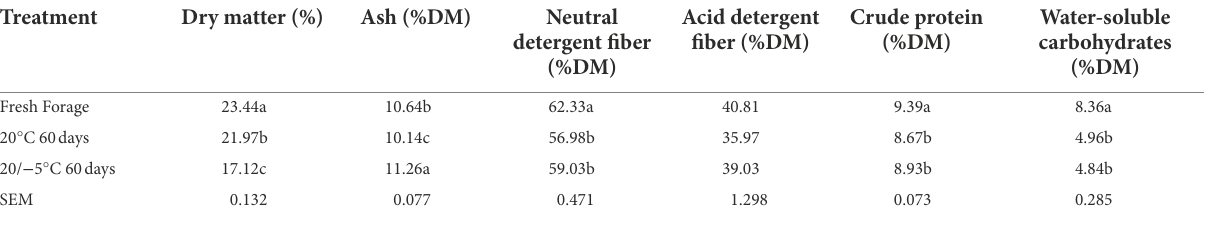
TABLE 2 Nutritional components in fresh forage and silage ensiled for 60 days.